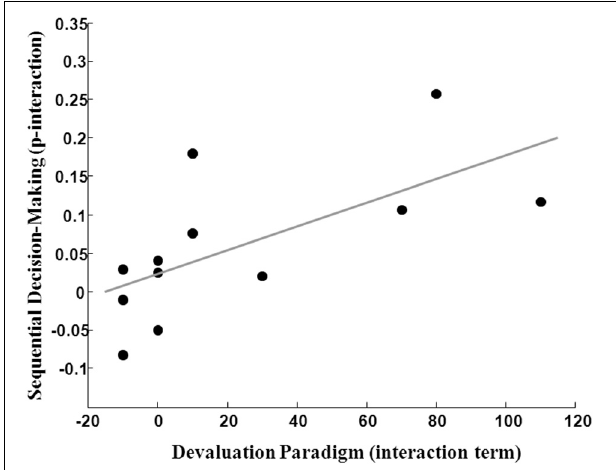
FIGURE 6 | Correlation of “model-based” [sequential decision-making (2-step) interaction term] and “goal-directed” (devaluation paradigm interaction term) behavior ( n = 12, Spearman R = 0 . 74, p = 0 .